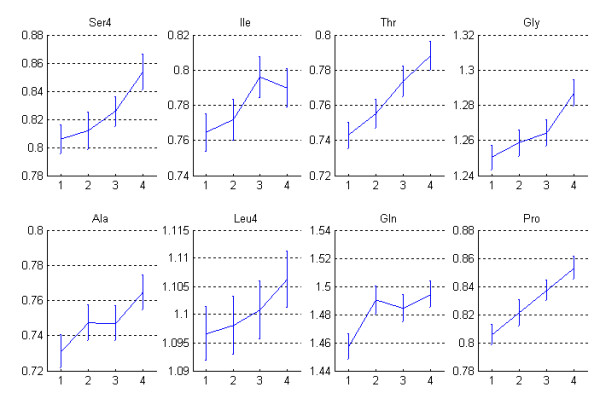
RMCU (vertical axis) of amino acids in Group A vs. breadth of expression. The bins on the horizontal axis represent breadth of expression as follows: bin 1: 1–5, bin 2: 6–9, bin 3: 10–13 and bin 4: 14–20.